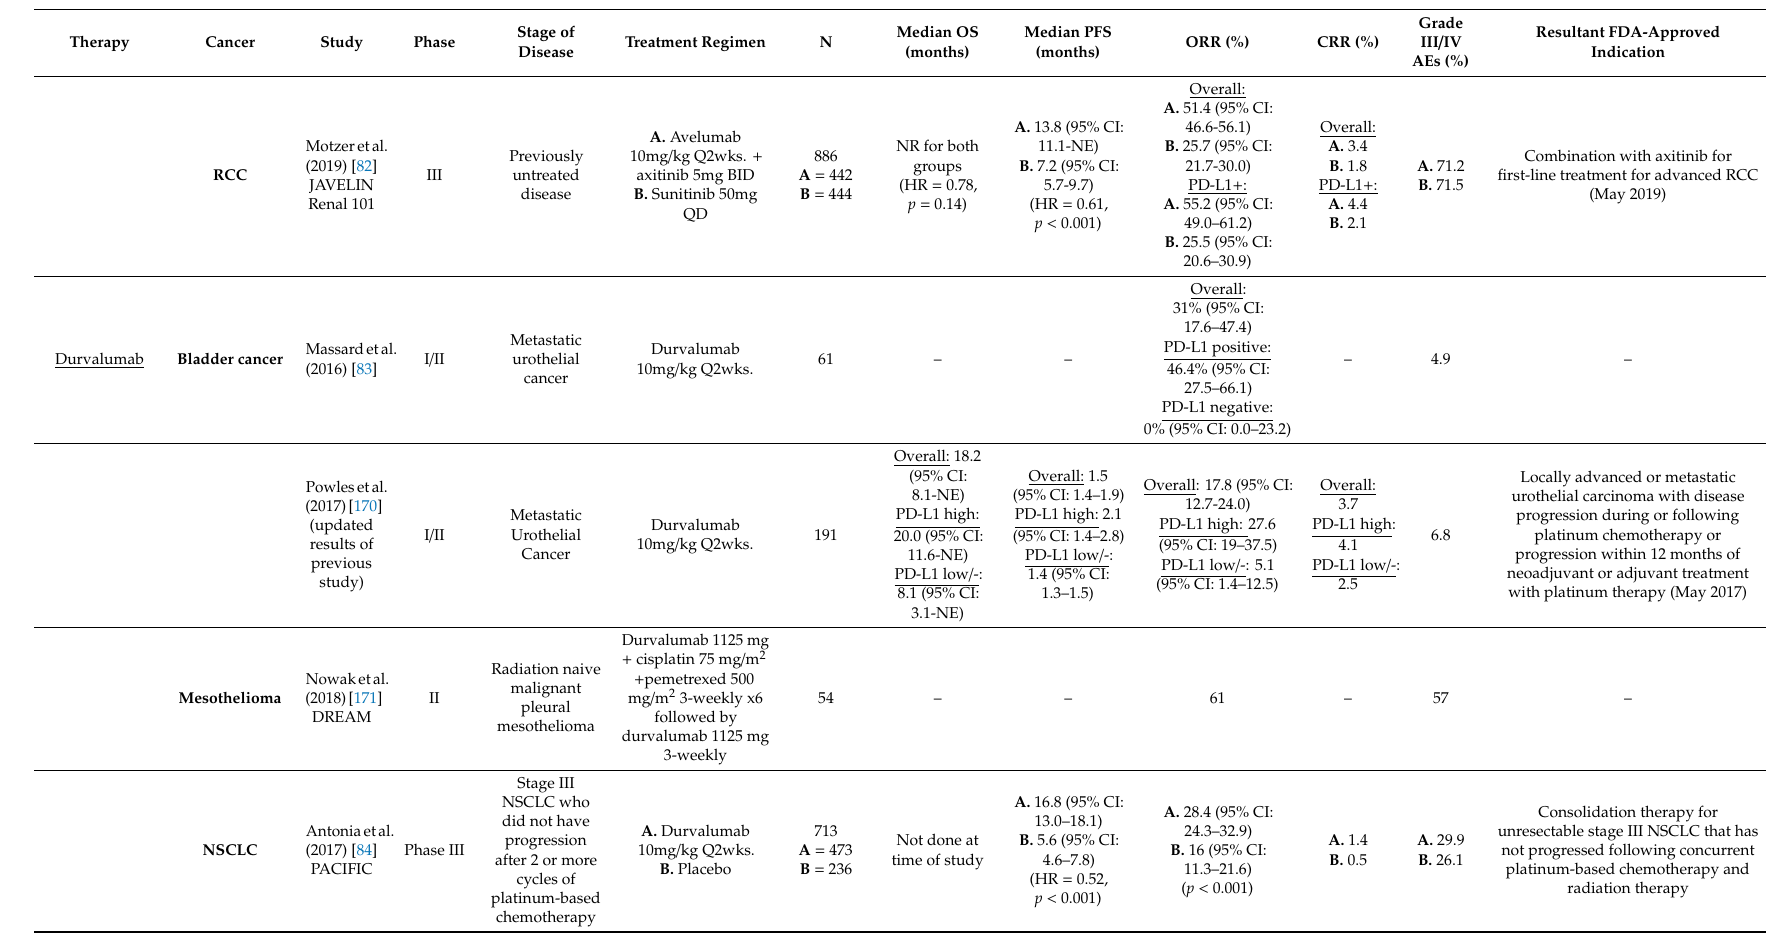
ALK = anaplastic lymphoma kinase, CI = confidence interval, EGFR = epidermal growth factor receptor, HR = hazard ratio, MCC = Merkel cell carcinoma, NE = not estimable, NR = not reached, NSCLC = non-small cell lung cancer, NsqNSCLC = non-squamous non-small cell lung cancer, RCC = renal cell carcinoma, SCLC = small cell lung cancer, TNBC = triple-negative breast